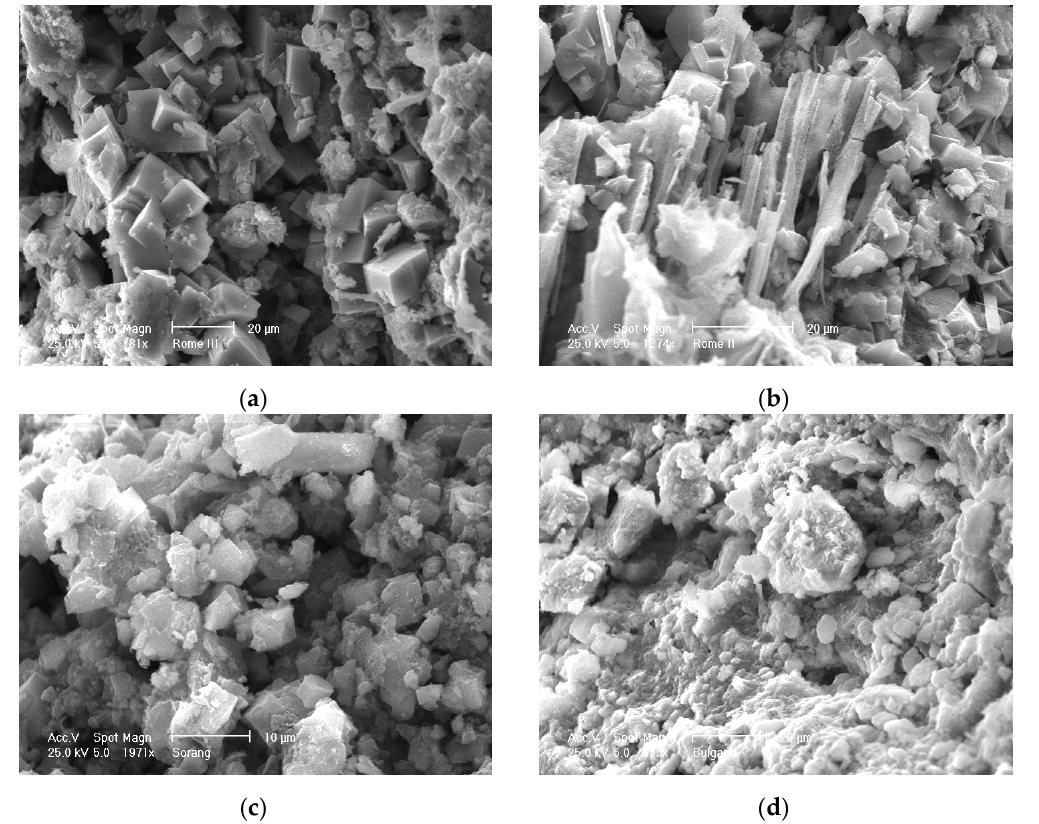
Figure 1. SEM micro-photographs of the Rome ( a , b ), Sorano ( c ) and Viterbo ( d ), zeolite tuff samples. Chabazite cubic crystals are observed in all photographs. The volcanic glass shards replacement by chabazite is noted in ( a ).